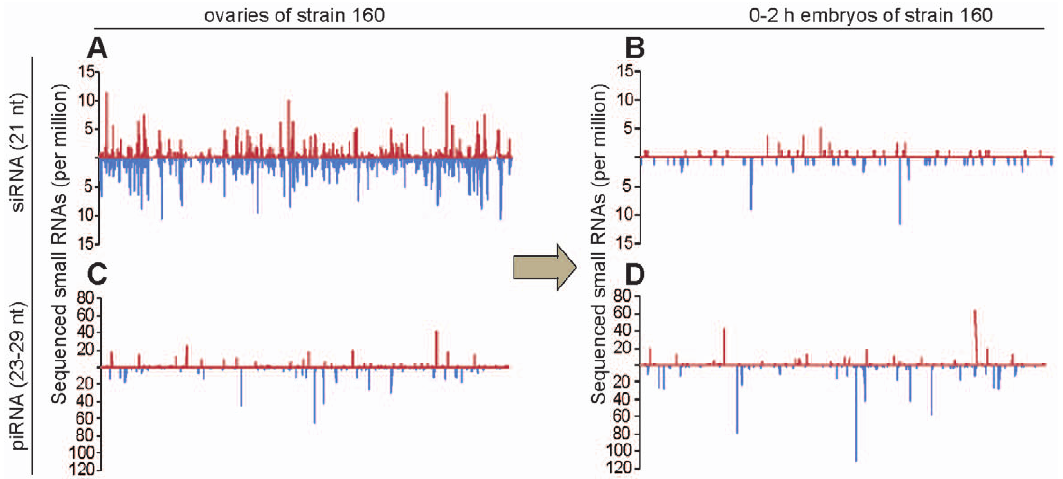
Figure 4. Maternal deposition and distribution levels of Penelope -derived small RNAs. siRNAs at (A, B) and piRNAs at (C, D) in strain 160 and its 0–2 h embryos. Sense small RNAs are indicated in red, antisense–in blue.